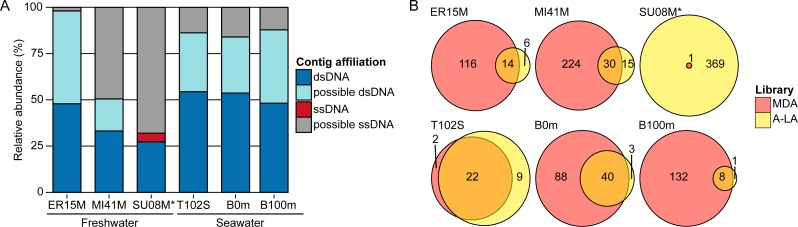
Relative abundance of ssDNA vs dsDNA viruses in freshwater and seawater samples and estimated diversity of ssDNA viruses.(A) Composition of A-LA viromes from 6 aquatic samples (based on the read coverage of assembled contigs). Contigs were affiliated based on best BLAST hit to NCBI RefSeq Virus (“dsDNA” and “ssDNA” contigs) or if not possible (no significant hit or mixed hits to both dsDNA and ssDNA genomes), based on their coverage in the TAG virome (“predicted dsDNA” if covered in TAG virome, “predicted ssDNA” otherwise). Relative abundance was calculated based on the coverage of each contig by virome reads. ER15M: Lake Erie, MI41M: Lake Michigan, SU08M: Lake Superior, T102S: surface sample of station Tara Ocean 102, B0m and B100m: surface and 100 m-deep samples from the Bermuda Atlantic Time-series Study site collected in March 2011. (B) Comparison of ssDNA viruses contigs recovered in MDA and A-LA library. For each sample, a Venn diagram depicts the number of contigs affiliated to ssDNA detected in MDA, A-LA, and both libraries (contigs detection based on a mapping of the library reads). ∗For sample SU08M, a limited number of quality-controlled reads were available for MDA and LA libraries (∼1 order of magnitude less than for other samples).